Question: Reading the figure, is the described quantity rising or falling?
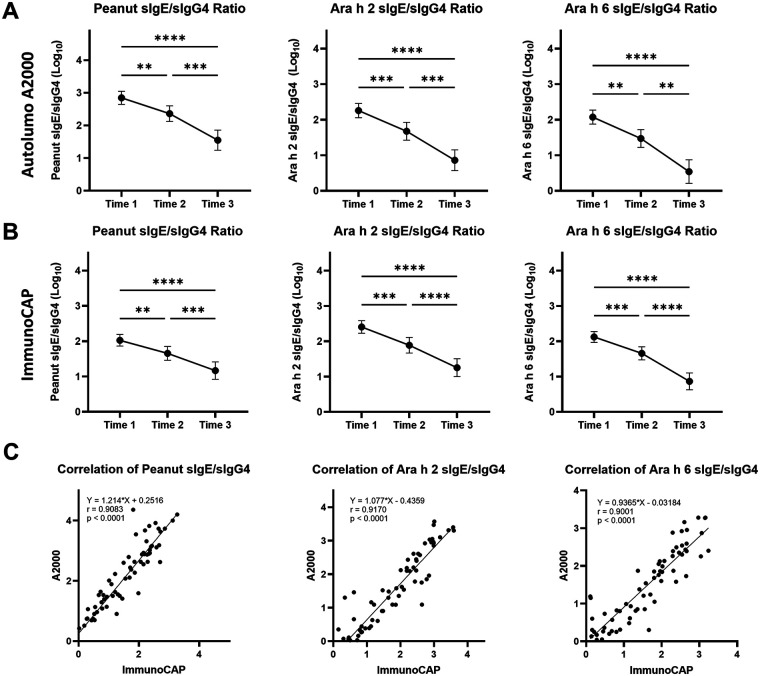
Answer: decreasing